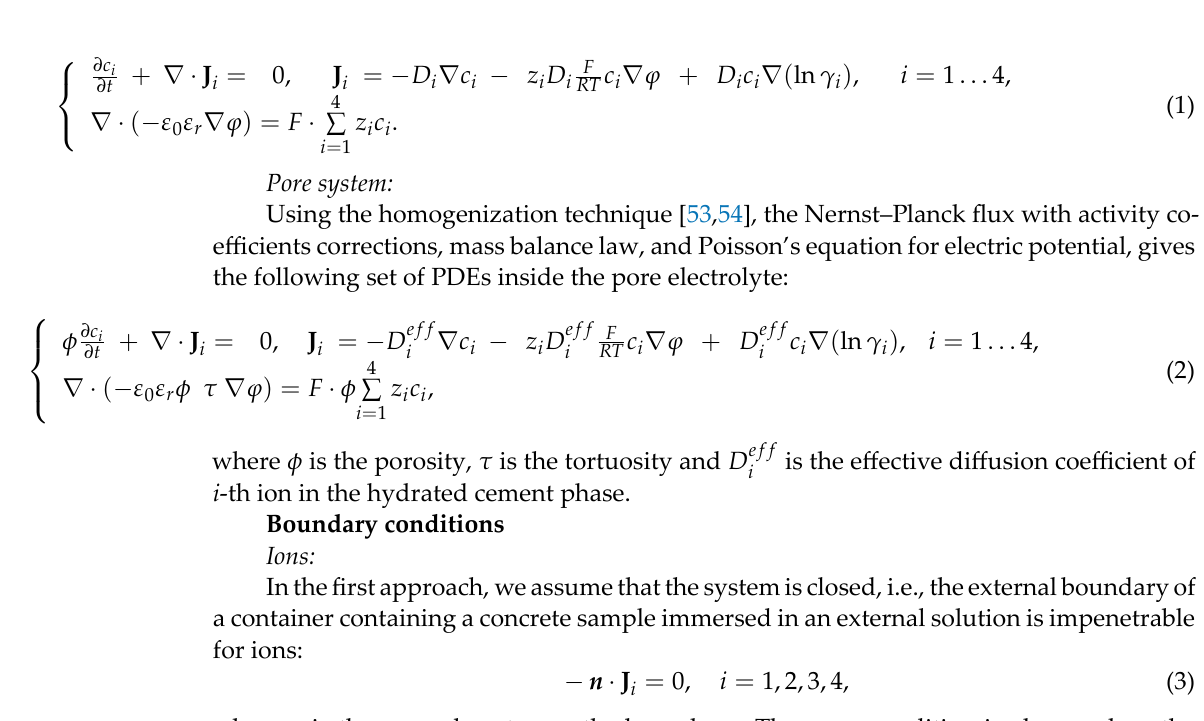
Table 1. Initial concentrations of ions in liquid in pores of cementitious material c 0 The symbol I denotes molar ionic strength of the solution; c 0 − 3 c 0 (mol m i , pore